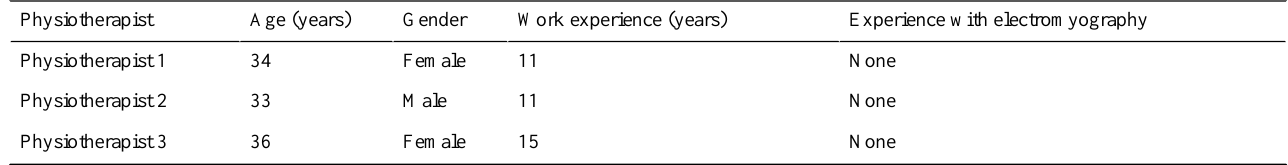
Table 1. Characteristics of